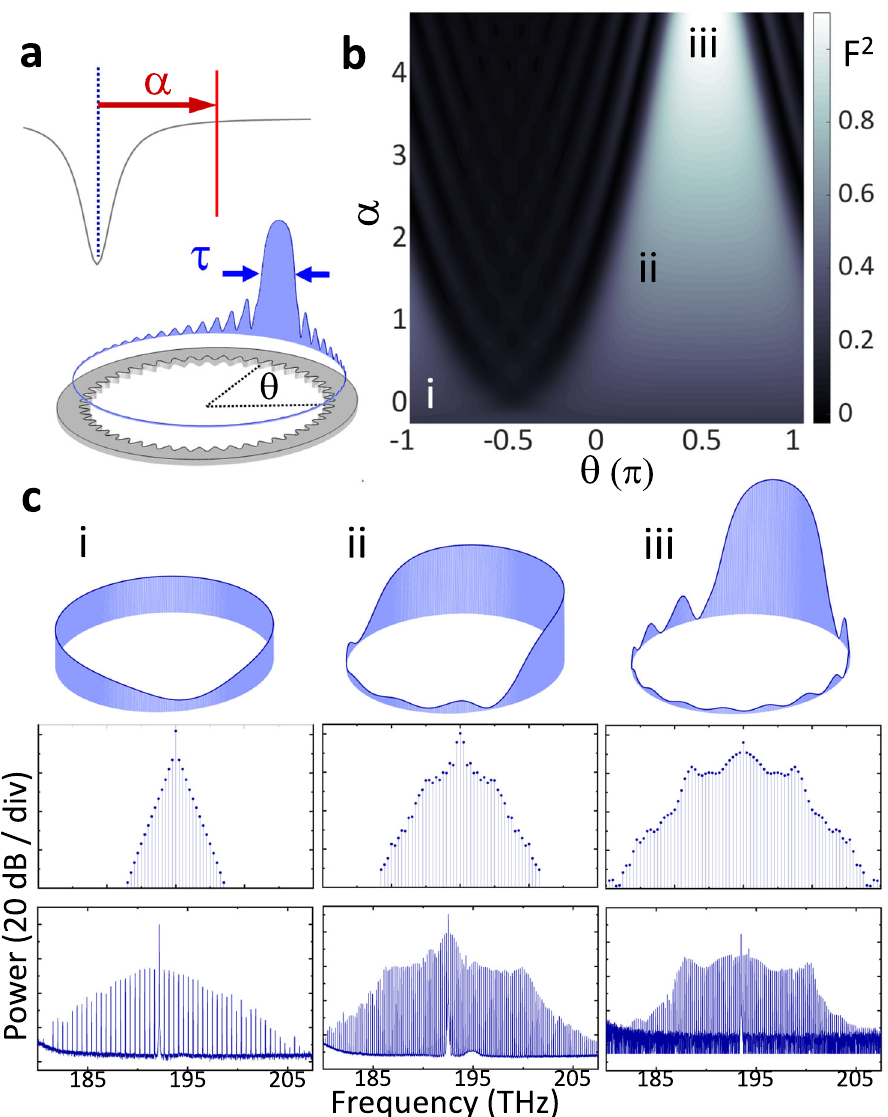
Fig. 1 Phenomena of the pulse continuum. a Illustration of the relation between detuning α and pulse width τ . b Continuous pump detuning sweep showing i dark pulse, ii half- fi lled, and iii bright-pulse states. c Simulated intensities (top), spectra (middle), and measured spectra (bottom) of each state i – iii